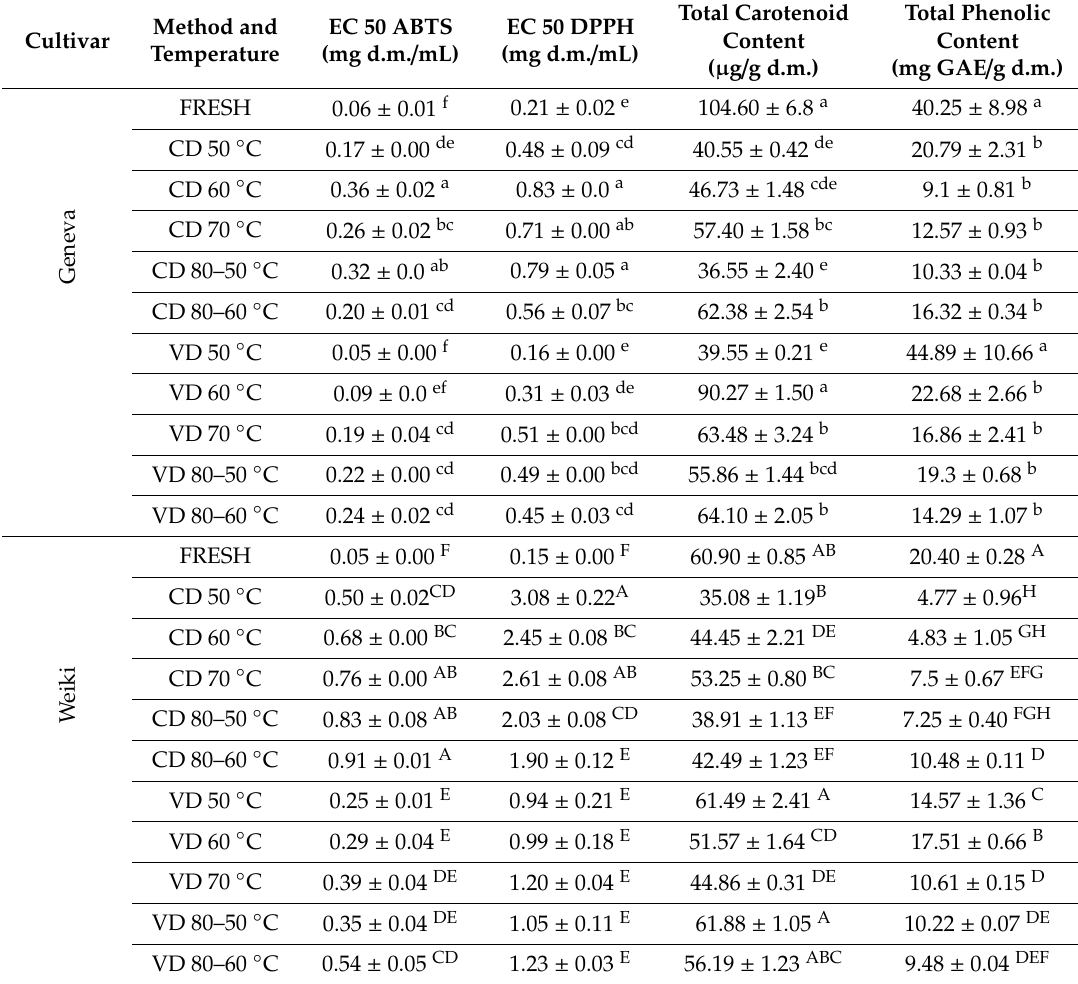
Table 2. Biochemical properties of dried kiwiberry samples.